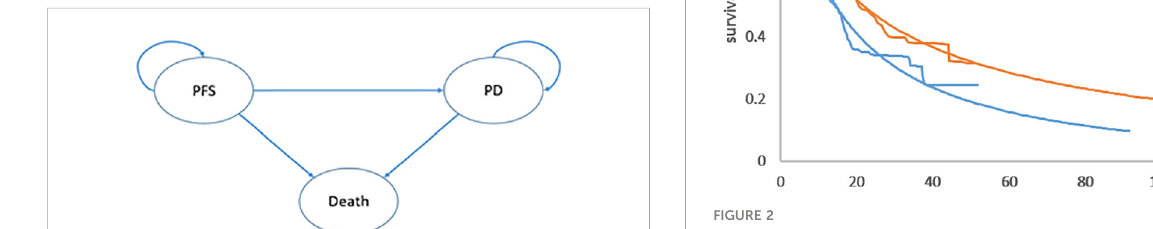
FIGURE 1 Model structure.